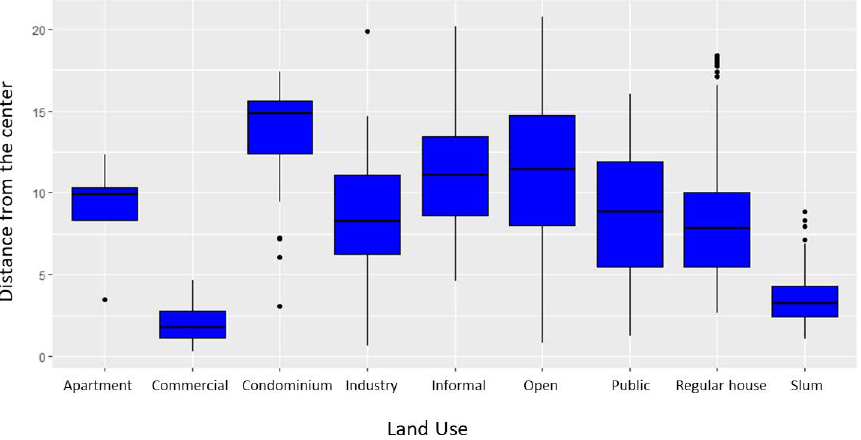
Figure 17. The land use distribution plotted against the distance from the city center in kilometers.